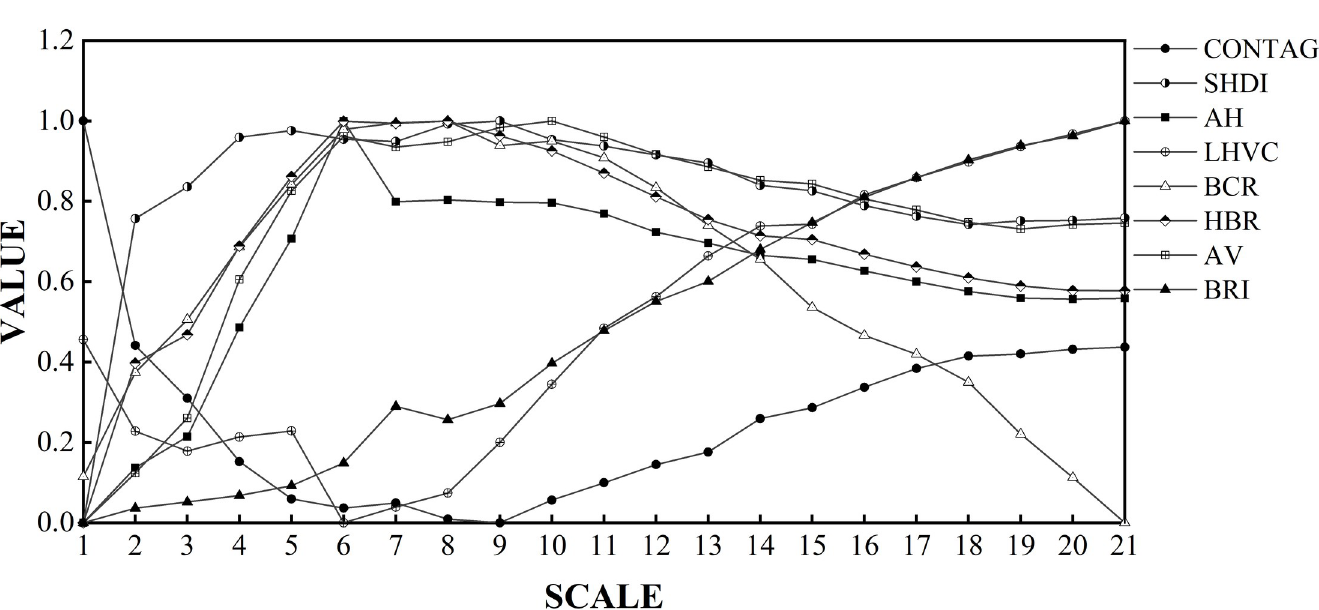
Fig 6. Scale-effect plot of eight architectural landscape pattern